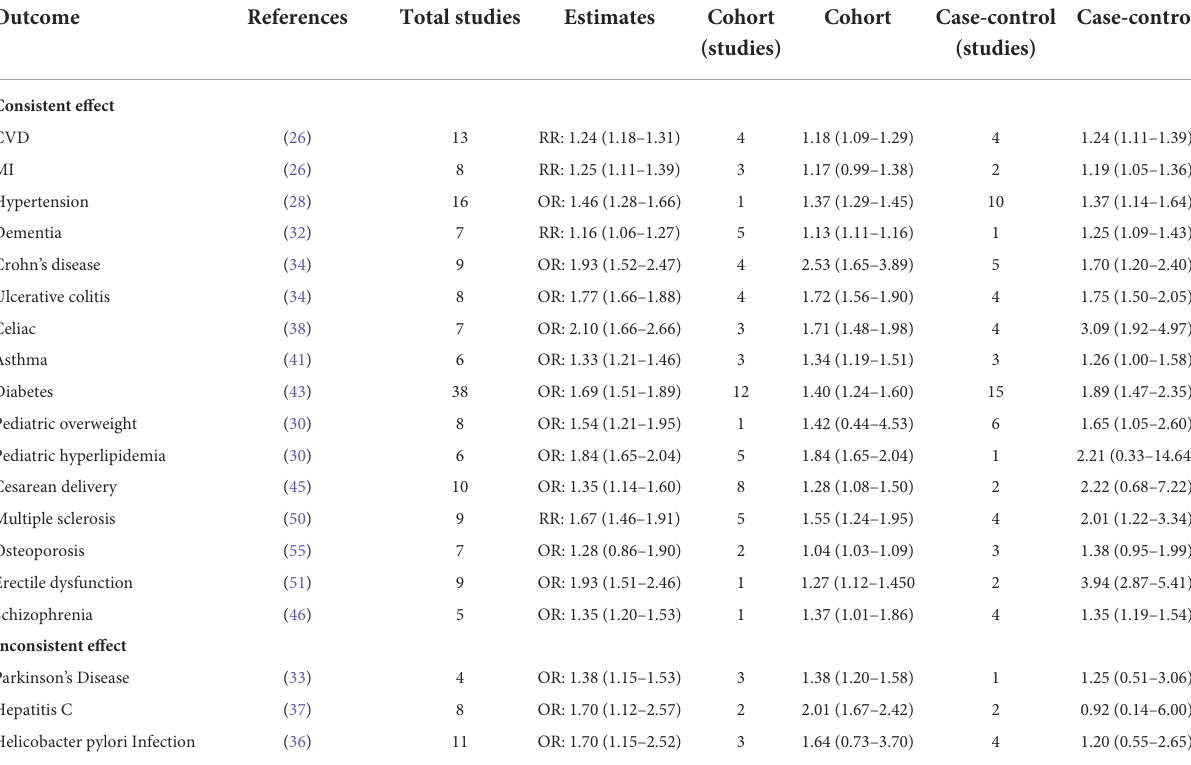
TABLE 2 Subgroup analysis results by study